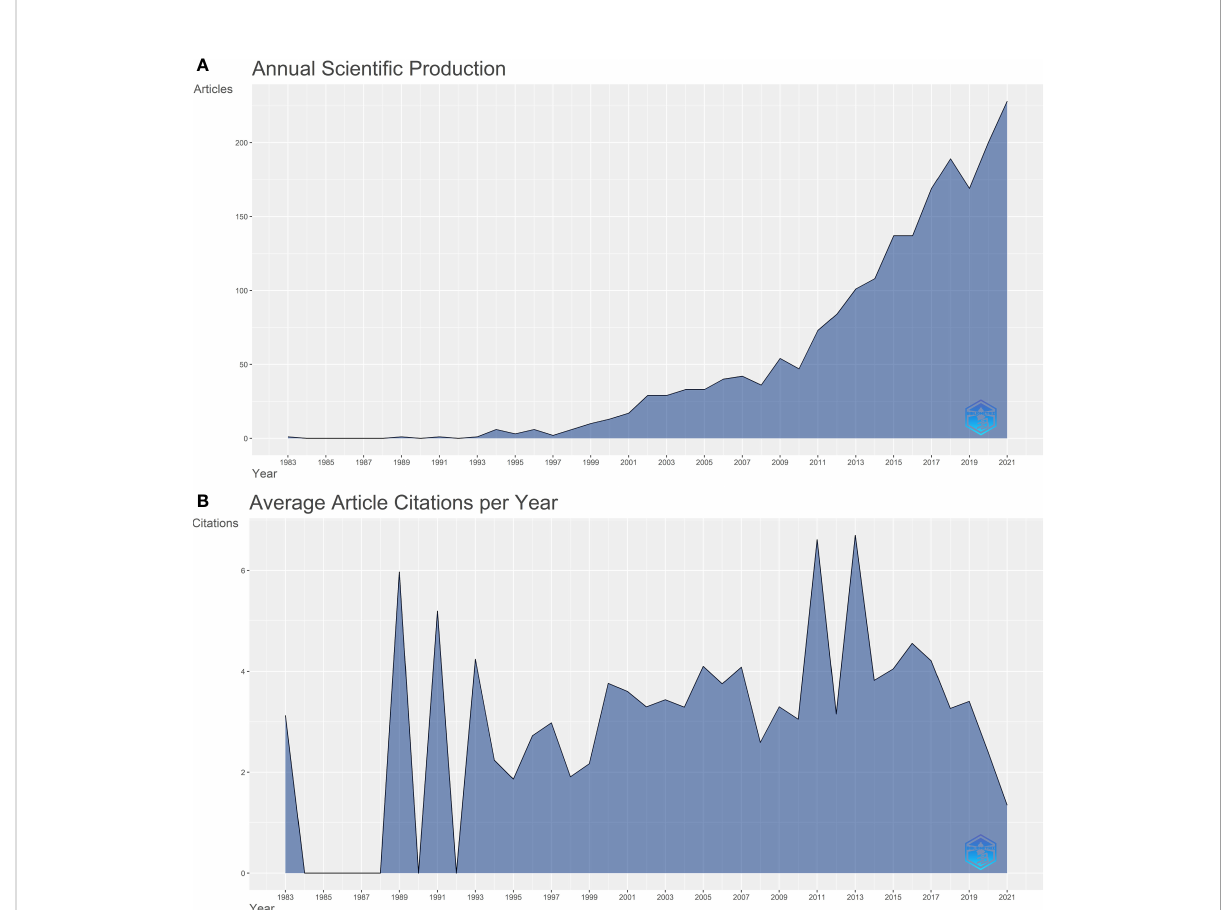
FIGURE 1 (A) A line chart of the number of publications published each year, 1983-2021. (B) A line chart showing the average number of citations per article per